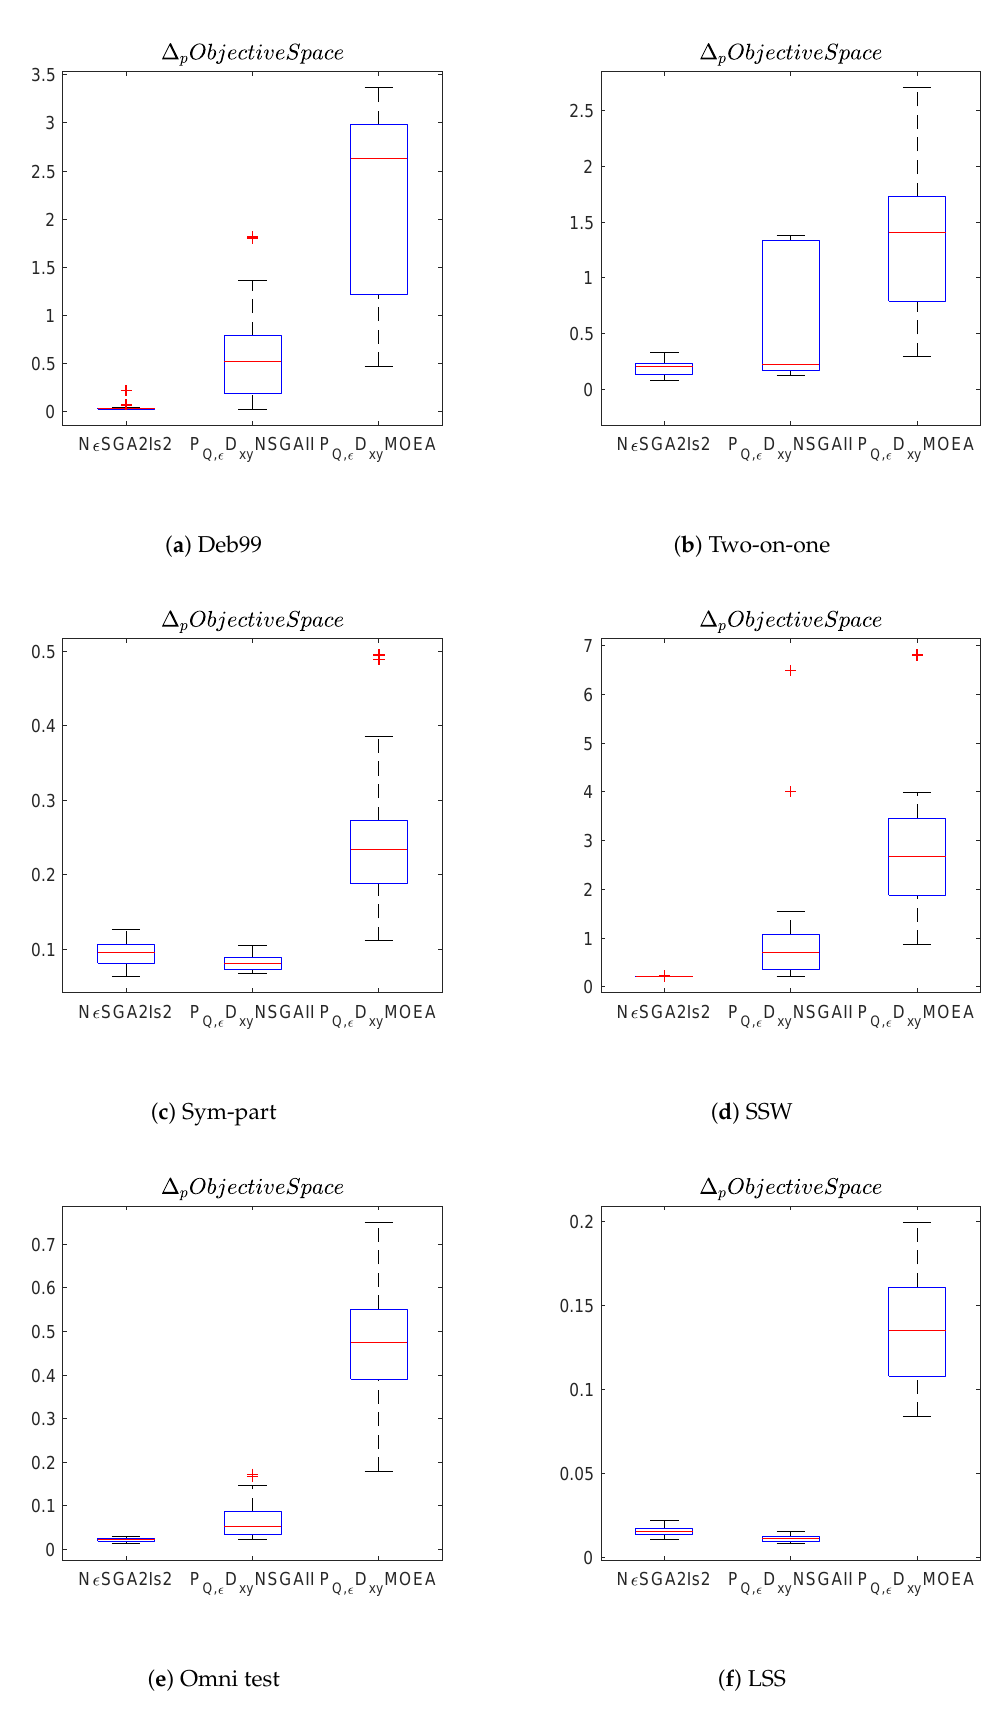
Figure 9. Box plots of ∆ 2 in objective space of N e SGA, P Q , e D xy -NSGA-II and P Q , e D xy -MOEA/D from left to right.